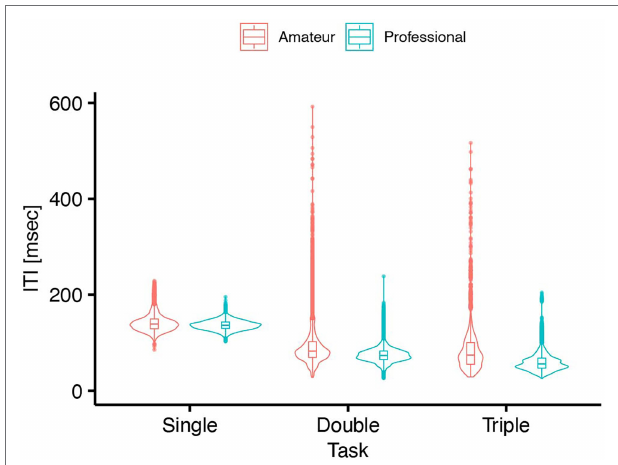
FIGURE 3 | Inter-tap interval of professional and amateur darbuka players in the single-, double- and triple-finger tapping tasks ( n = 8 for the professional group and n = 8 for the amateur group).